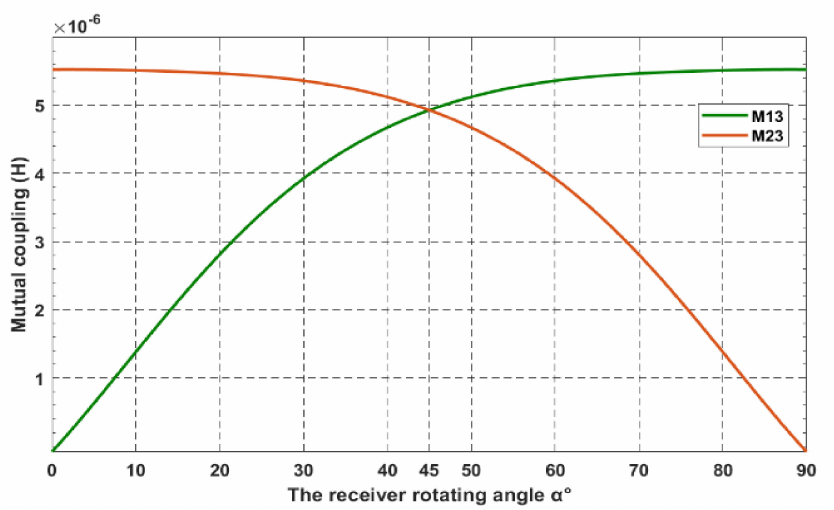
Figure 5. Mutual coupling when the receiver coil distance is fixed at d = 0.3 m and the angle α rotates from 0 ◦ to 360 ◦ through 1 ◦ step